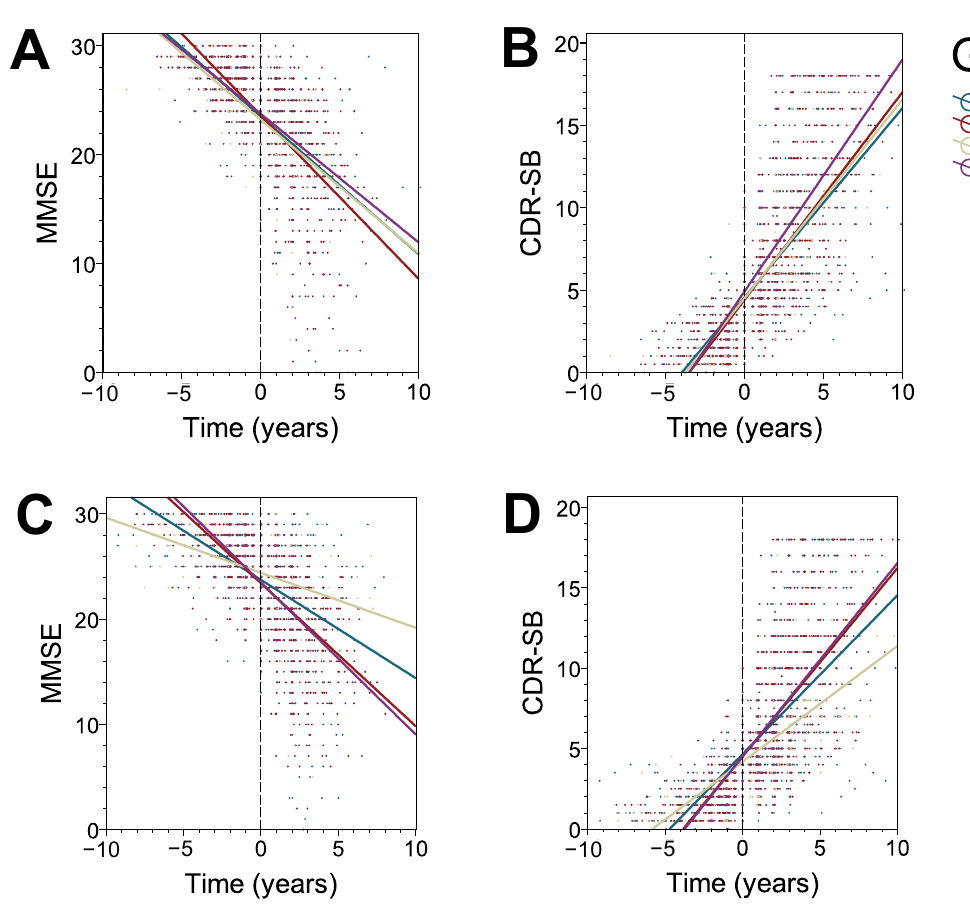
Figure 2. Protective effect of the KL -VS het+ status is clearly appreciated in male but not in female participants, who are APOE ε 4 allele non-carriers. Shown are nonparallel linear regression plots with distinctive slopes reflecting the interaction between KL -VS het+ status and APOE ε 4 allele carrier status on Mini-Mental State Examination (MMSE) ( A , C ), and Clinical Dementia Rating Sum of Boxes (CDR-SB) ( B , D ) separately in female ( A , B ) and male ( C , D ) participants. Solid colored lines represent lines of best fit through individual data points in a scatterplot. Negative time variable values represent the number of years before transition from MCI to AD dementia, and positive values represent the number of years after the transition to AD dementia. The 0 values represent the clinical visit a participant for the first time received a diagnosis of AD dementia. Table 5. Longitudinal LMM analyses investigating the effect of KL- VS het+ status for annualized rates of cognitive decline in ε 4 non-carriers stratified by sex, median baseline age, and median education level. For all comparisons, the reference group was KL- VS het − / ε 4 − .